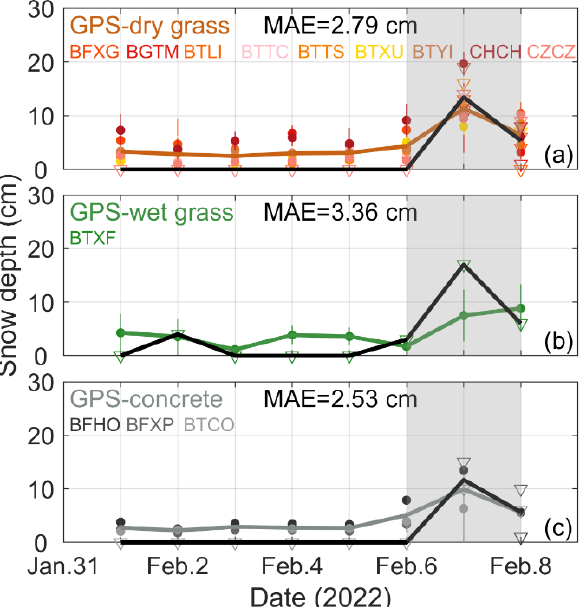
Figure 3. Comparisons of the GNSS-derived snow depths and the in situ measurements for the three groups with different surface conditions. ( a ) Dry grass. ( b ) Wet grass. ( c ) Concrete. The snow depth values for each site are the same color. GNSS-derived snow depth is marked with a solid circle, and the in situ snow depth is marked with a triangle. The colored line is the daily mean value of the GNSS results for multiple sites. The black line is the daily mean value of measured snow depth for the corresponding sites. The error bars are defined as the standard errors of all of the available tracks. Some small error bars are hidden behind the markers.